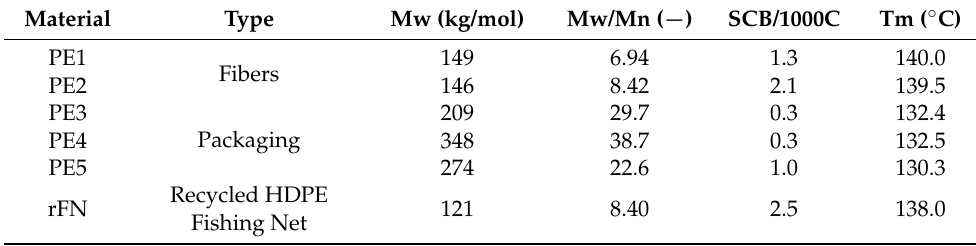
Table 1. Physicochemical properties of raw resins and recycled fishing net